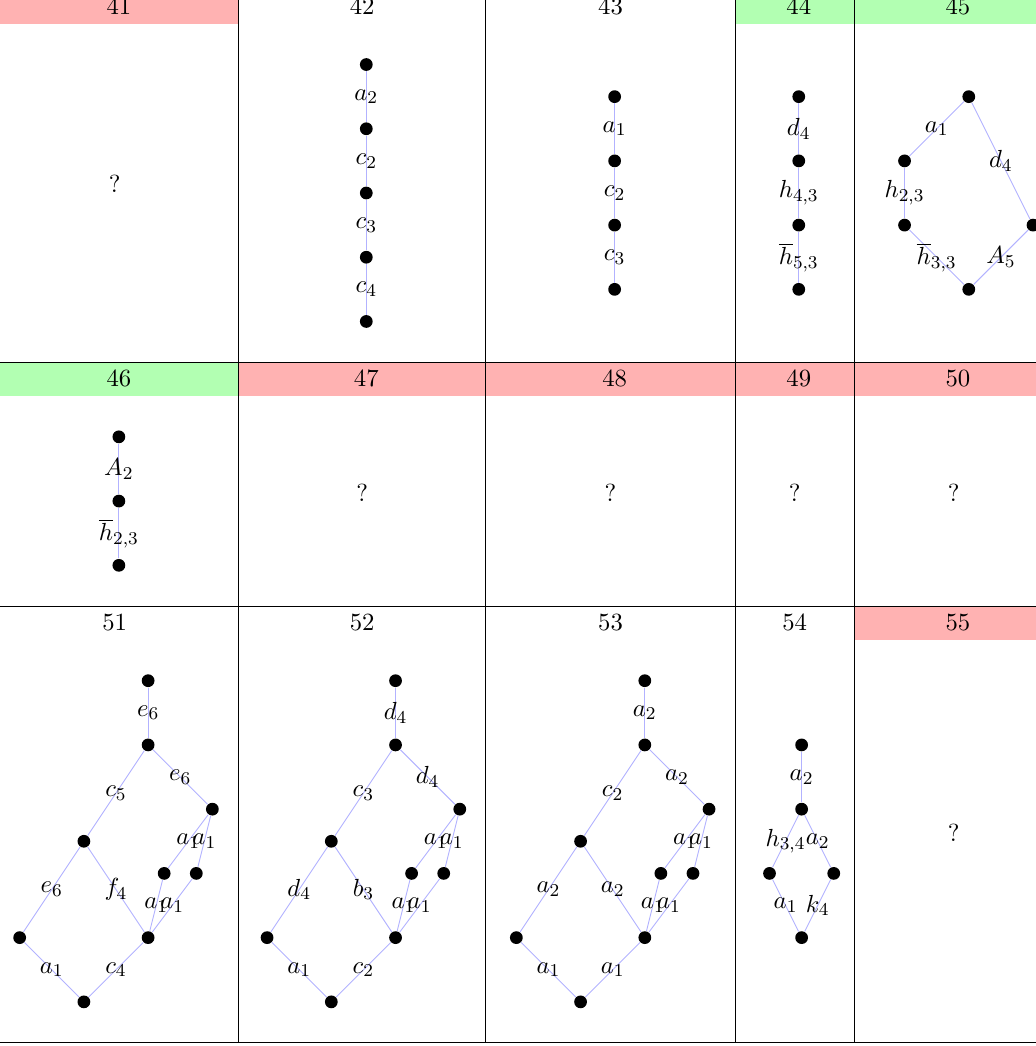
Table 10 . Hasse diagrams deduced from unitary magnetic quivers by quiver subtraction (contin-